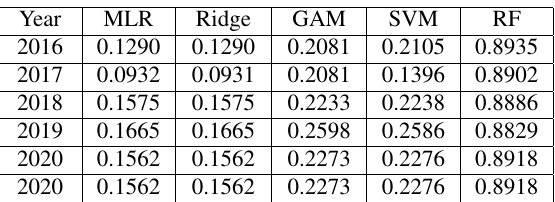
Table 4. Models’ R 2 (Predicted vs Derived).